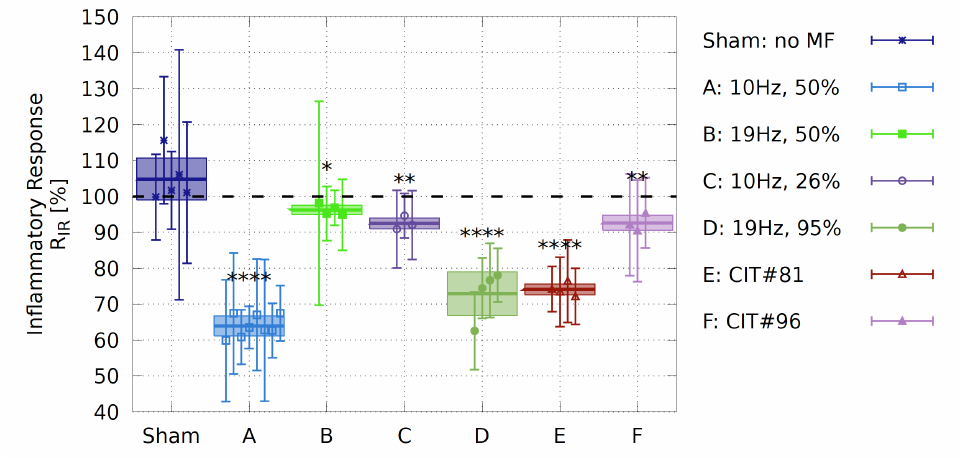
Figure 5. Effect of magnetic-field exposure on inflammatory response in HEK-Blue™ hTLR4 cell ( i ) cultures. Each data point ( i ) is represented by the ratio R in the inflammatory responses (Supple- IF ment, Equation S8a). Box plots represent the mean over the biological repeats ± standard deviation. Sham experiment: experiments were conducted without magnetic-field exposure in both of the incubators and served as a measurement of the background variation between identical experiments. MF-exposure conditions are described in Section 2.2 and the data is shown in the Supplement, Tables S3 and S4. N: number of biological repeats (Sham N = 5, A N = 8 , B N = 3, C N = 4, D N = 4, E N = 4, F N = 3); p < 0.0001 ****, p < 0.01 **; p < 0.05 * represent p -value